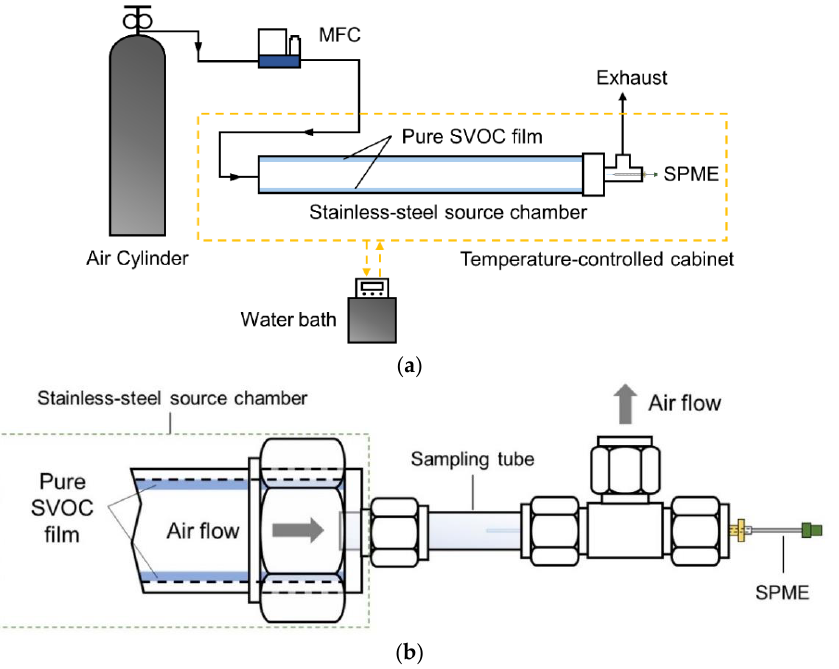
Figure 2. Illustration of ( a ) the experimental system and ( b ) the connection of the SPME-based active sampler to the source chamber. sampler to the source